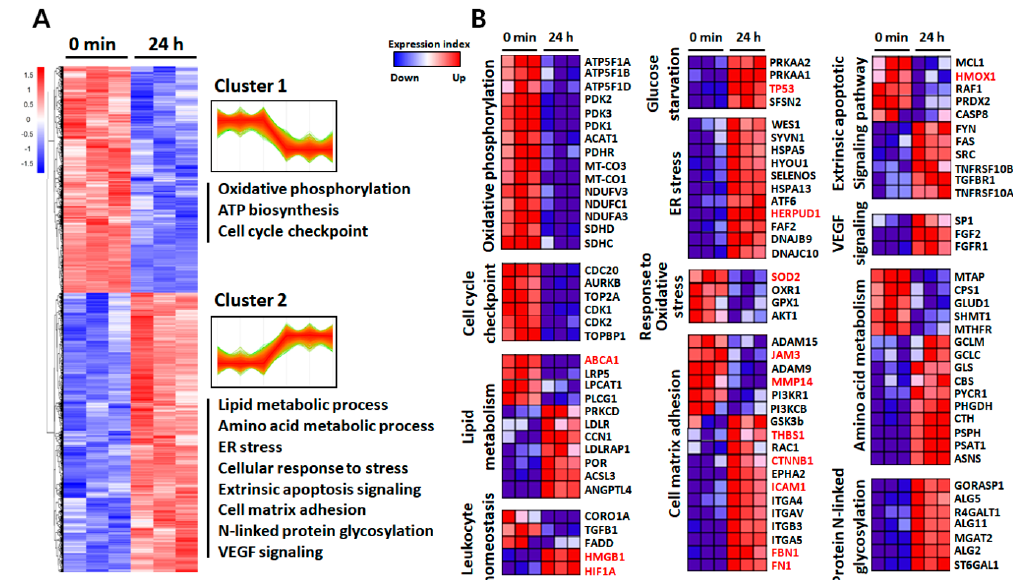
Figure 3. Visualization of changing proteins and their biological pathways. ( A ) Hierarchical cluster (HCL) analysis of differentially expressed proteins upon 24 h treatment of 50 μ g/mL LPS, according to their abundance profile with significantly enriched biological process gene ontology (GO) terms within clusters. ( B ) Heat maps of the most enriched proteins between groups that strongly contributed to pathway enrichment scores (ES) in gene set enrichment algorithm (GSEA).